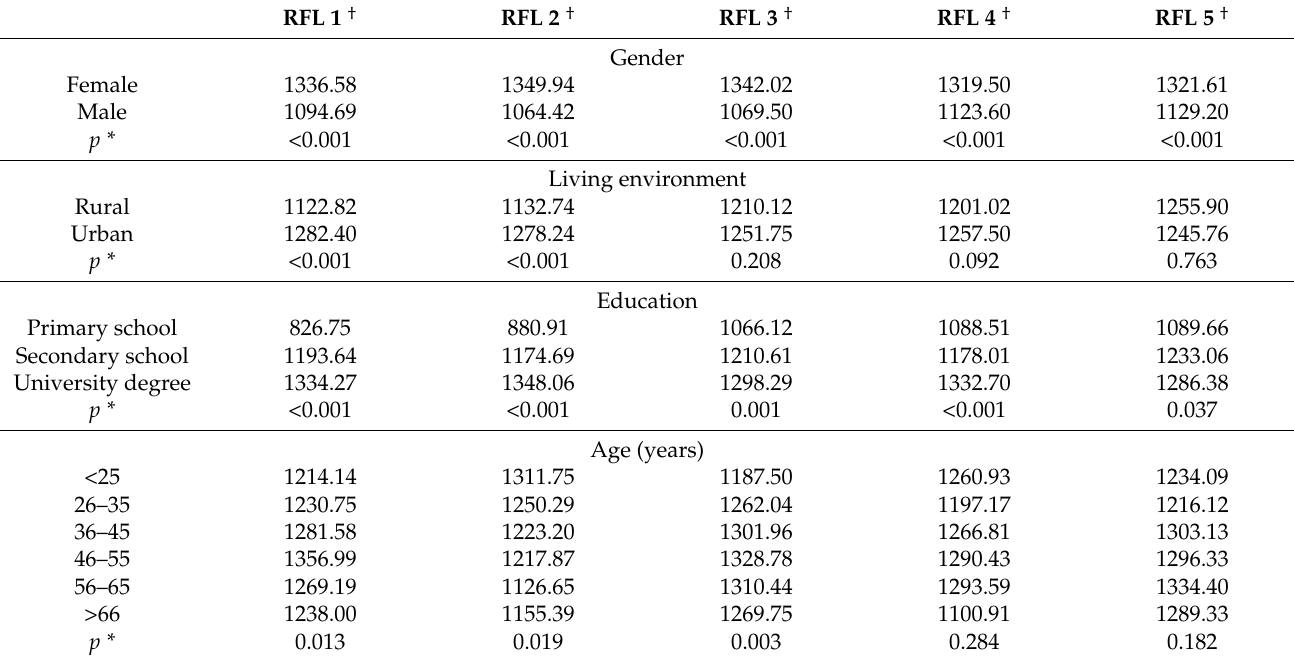
Table 2. Food label reading habits presented by gender, living environment, education, and age for a sample of residents from Croatia (N =